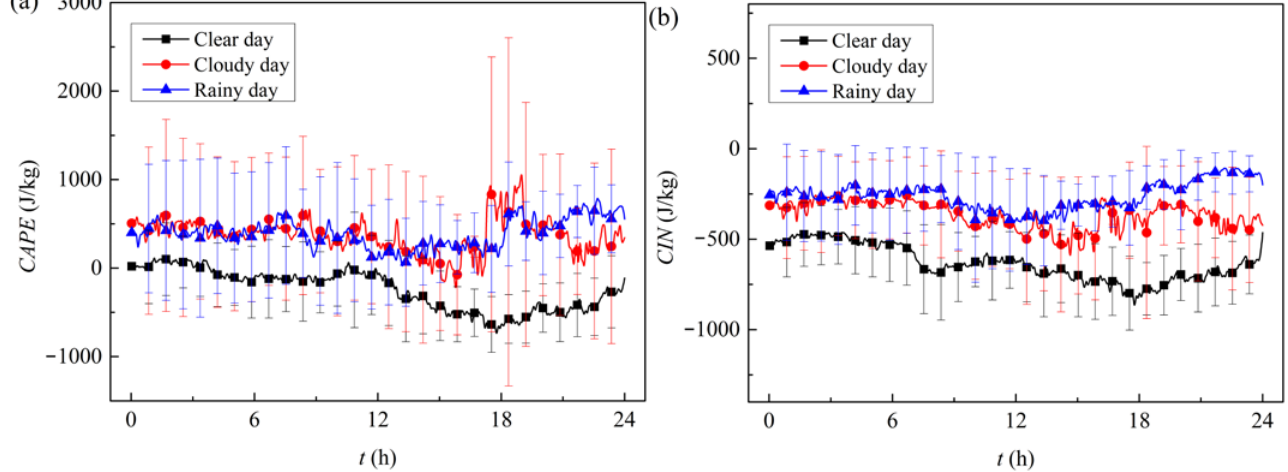
Figure 7. Statistical characteristics of stability indices (whole day, monsoon) season under different weather conditions. ( a ) CAPE , ( b ) CIN . The t (h) is expressed in UTC+8.